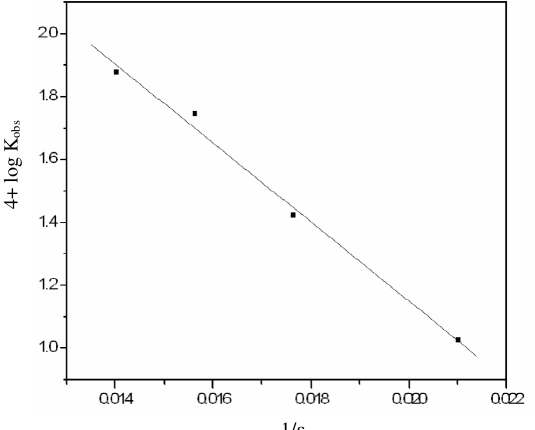
Figure 3. Plot of log k versus 1/ ε for the oxidation of PTAA with NCSA obs